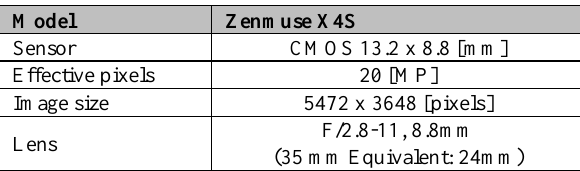
Table 6. Main specifications of Zenmuse X4S camera.